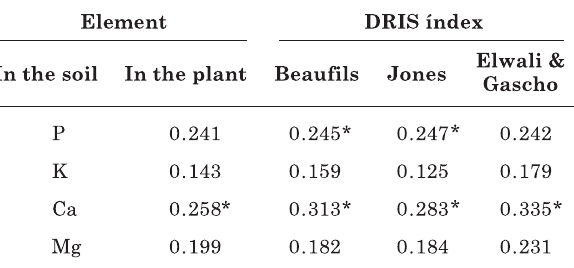
Table 3. Pearson correlation matrix of P (mg kg -1